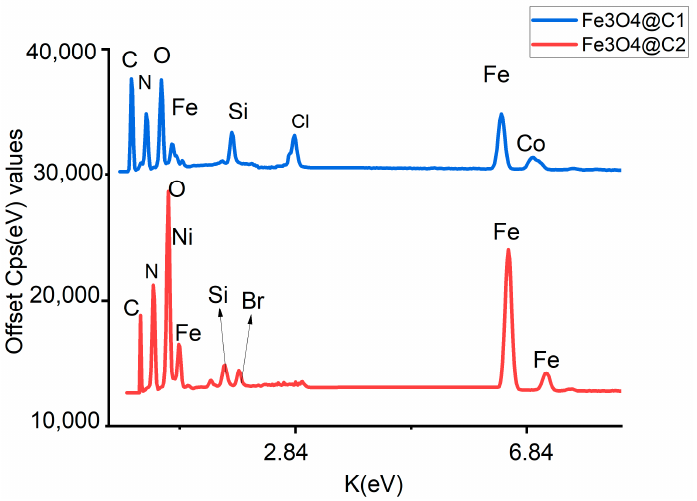
Figure 4 . The EDS spectra of Fe 3 O 4 @C1 and Fe 3 O 4 @C2 nanoparticles. Figure 4. The EDS spectra of Fe 3 O 4 @C1 and Fe 3 O 4 @C2